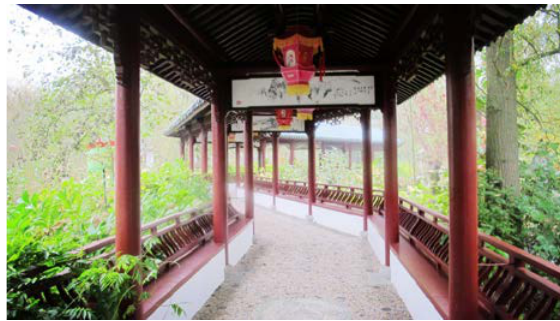
Figure 3.the long corridor in Pairi Daiza